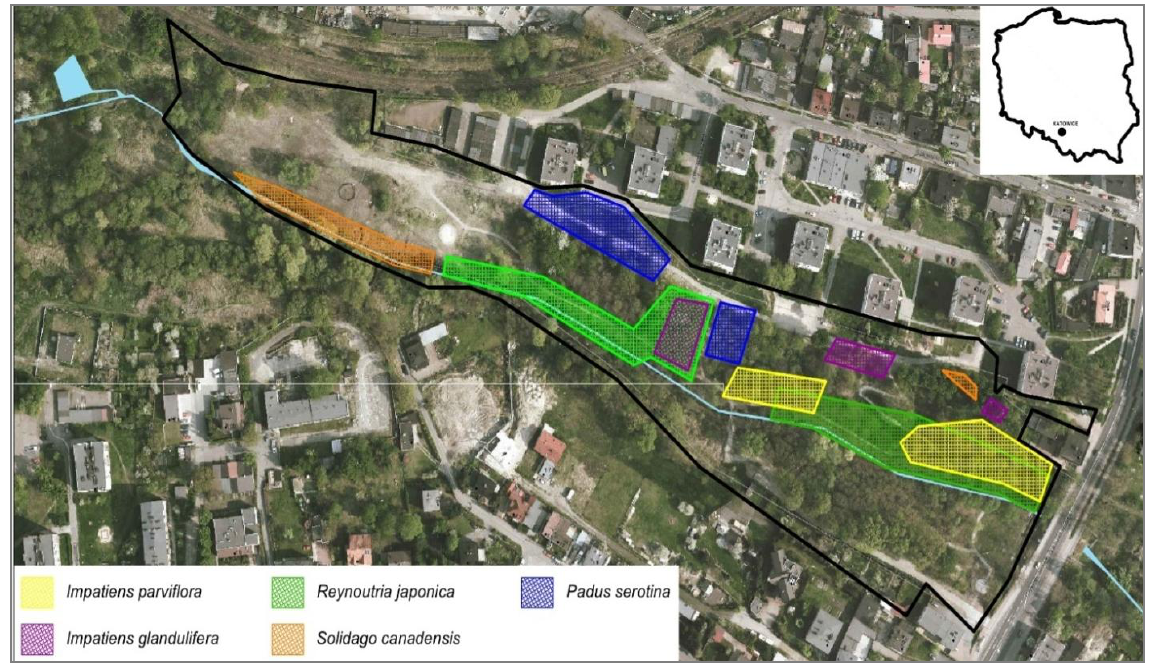
Fig. 1. Location of the study area, including the area of elimination of invasive plant species in the Ślepiotka river valley in